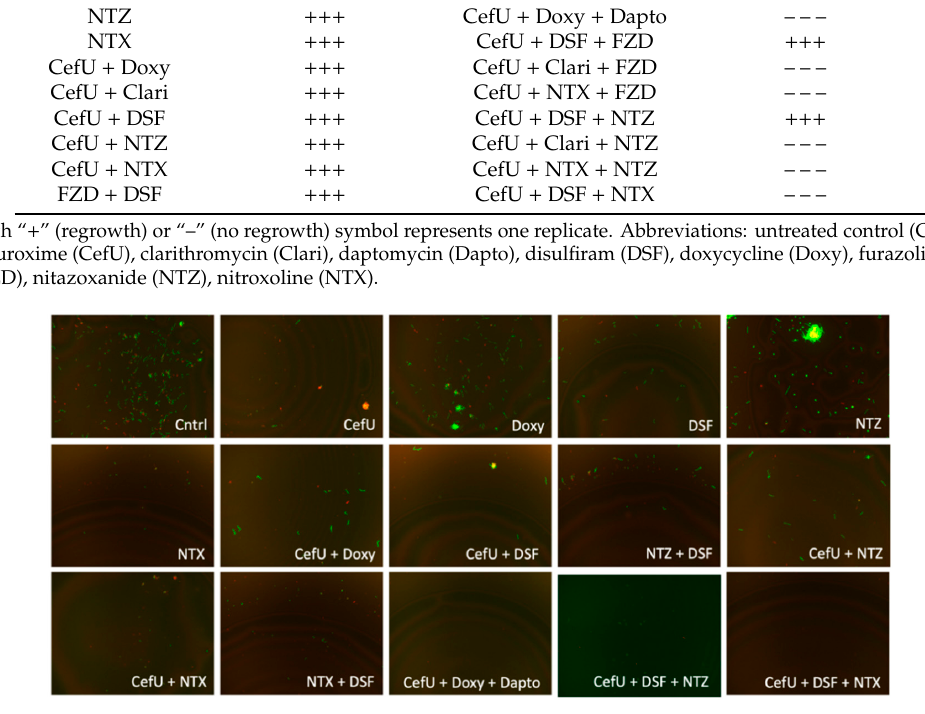
Figure 3. Subculture for single drugs, as well as for two-drug and three-drug combinations. Abbreviations: untreated control (Cntrl), cefuroxime (CefU), daptomycin (Dapto), doxycycline (Doxy), disulfiram (DSF), doxycycline (Doxy), nitazoxanide (NTZ), nitroxoline (NTX). Antibiotics 2020 , 9 , x FOR PEER REVIEW